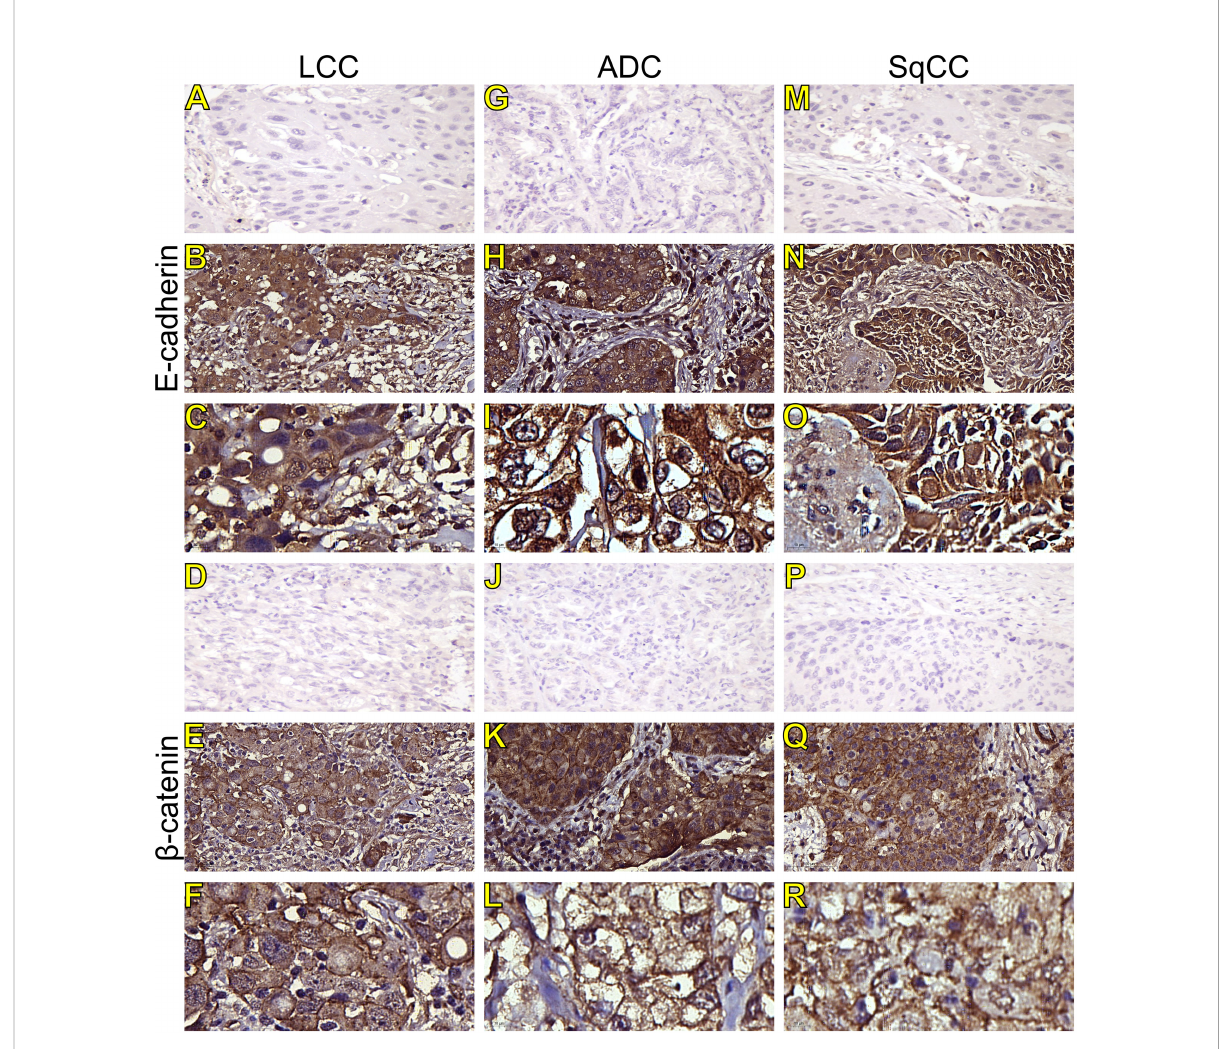
FIGURE 2 Immunohistochemistry expression of epithelial-to-mesenchymal transition-related markers in tumors and invasive groups of large cell carcinoma ( B, C , E-cadherin; E, F , b -catenin; respectively), adenocarcinoma ( H, I , E-cadherin; K, L , b -catenin; respectively) and squamous cell carcinoma ( N, O , E-cadherin; Q, R , b -catenin; respectively) (N=120). For both markers, the fi rst line illustrates the negative control (A, D, G, J, M, P) . Original magni fi cation: 40X and 100X. LCC, large cell carcinoma; ADC, lung adenocarcinoma; SqCC, lung squamous cell